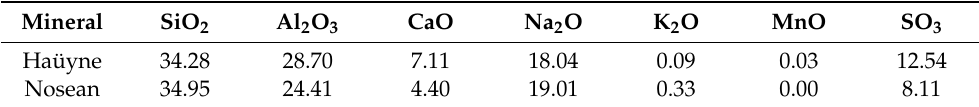
Table 2. Chemical composition of natural haüyne (Badakhshan, Afghanistan [25]) and nosean (Covao, Cabo Verde [25]).